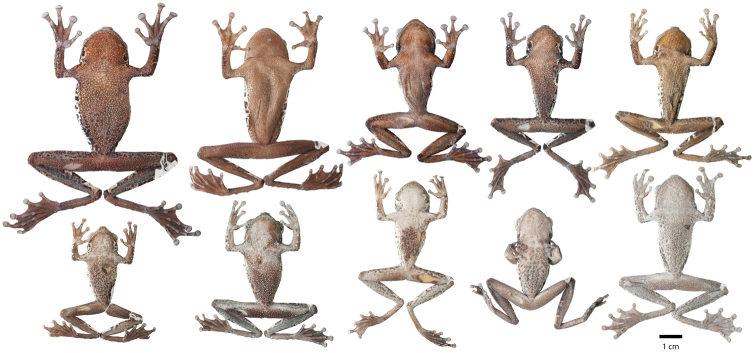
Adult Osteocephalus cannatellai showing variation in ventral coloration of preserved specimens. Specimen identity and arrangement is the same as in Figure 8. All specimens are shown at the same scale.